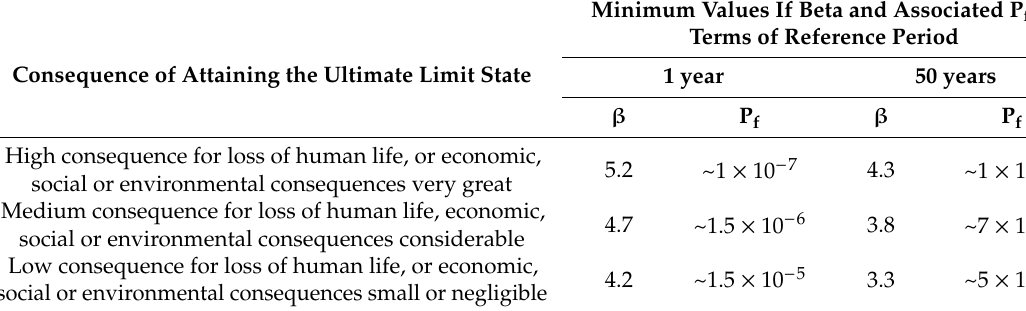
Table 1. Suggested values of reliability index (after